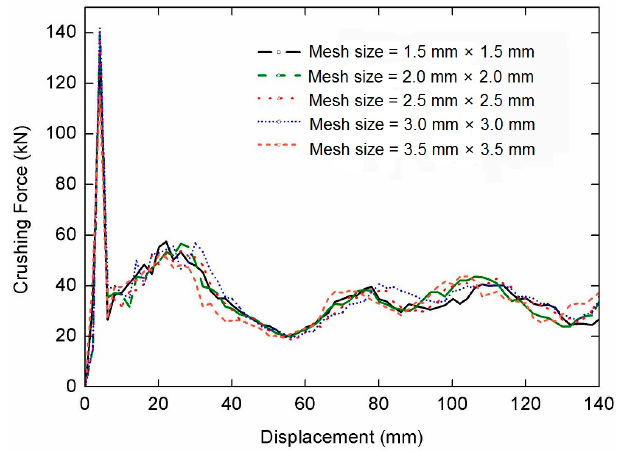
Figure 9. Crushing force versus displacement curves of FE models with five kinds of mesh sizes.